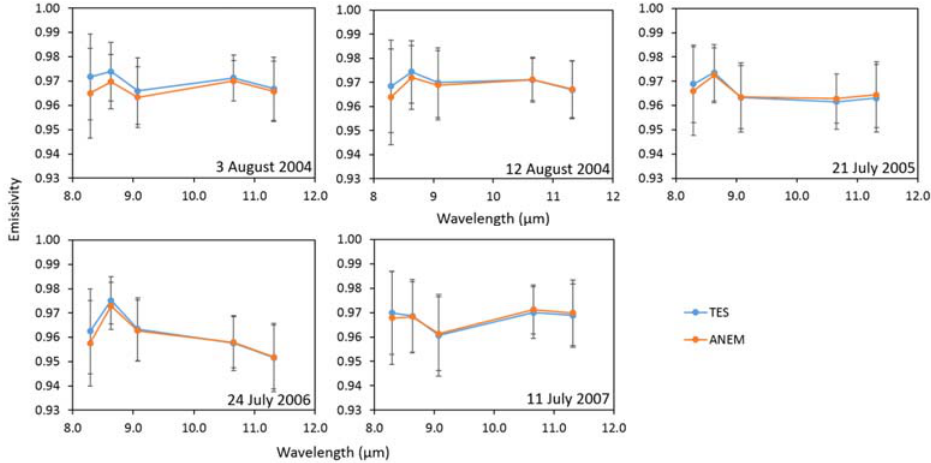
Figure 9. Mean emissivity retrieved with TES and ANEM methods using the pixels classified as urban area for the five thermal ASTER bands.